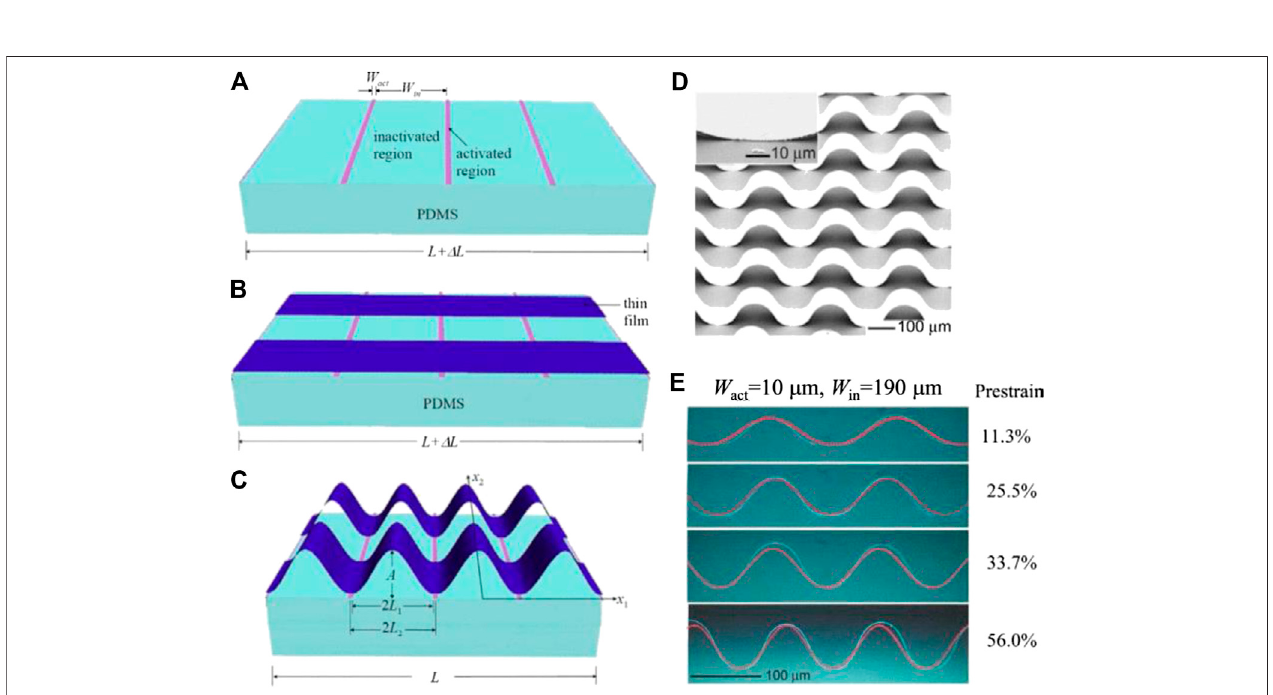
FIGURE4|(A) PrestrainedPDMSwithperiodicactivatedandinactivatedpatterns. (B) Thin fi lmparalleltothepre-straindirectionisattachedtotheprestrainedand patterned PDMS substrates. (C) Relaxation of the pre-strain in the PDMS leads to buckles of the nanoribbons. (D) SEM image of buckled GaAs nanoribbons formed using (A) – (C) . (E) Buckled GaAs thin fi lms on patterned PDMS substrate for different prestrain levels. Red line: calculations; blue line: experimental data (Song et al., 2009). Reproduced with